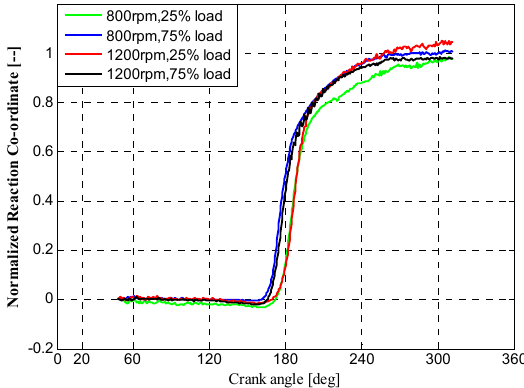
Figure 13. Normalized reaction coordinate at four working conditions.